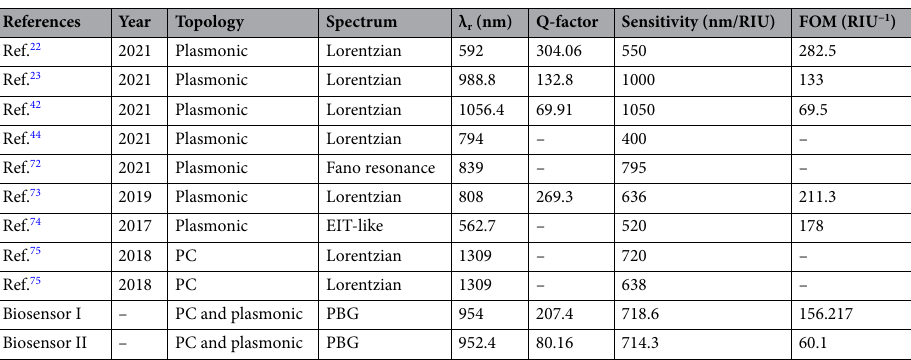
Table 1. Performance comparisons between the proposed sensors and other